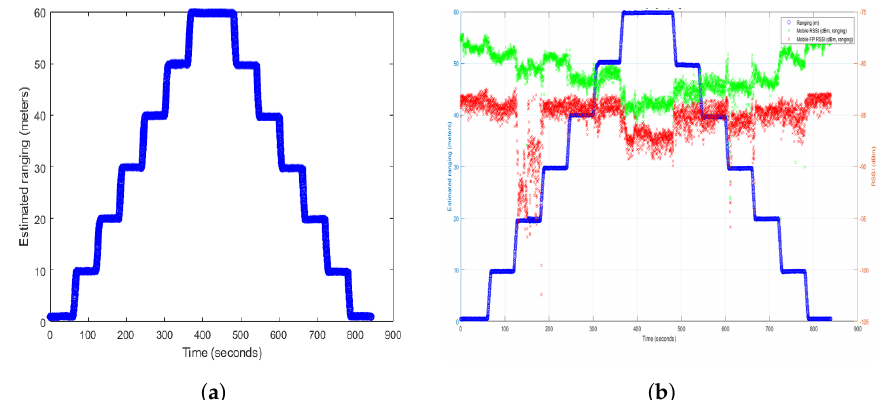
Figure 17. Estimated ranging and RSSI Test 1. ( a ) Estimated ranging of the UWB ranging link. ( b ) Estimated ranging of the UWB ranging link and RSSI of the UWB communications link.